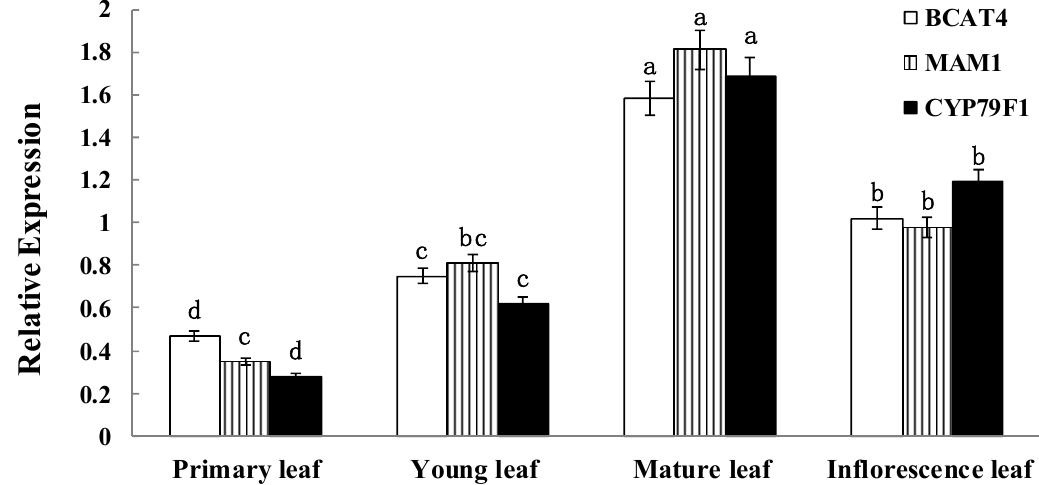
Figure 3. Temporal expression patterns of BCAT4 , MAM1 and CYP79F1 . The stages are defied as: primary leaf (15 days), young leaf (30 days), mature leaf (60 days) and inflorescence leaf (anthesis). Each bar represents the mean (±standard error) of three independent biological replicates. Different letters on the top indicate significant differences at p < 0.05.